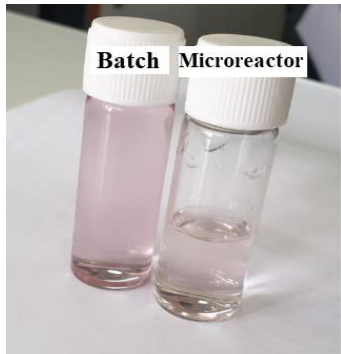
Figure 13 . Colors for GNPs samples prepared in a microreactor at 328.15 K. (Cons of SC, SB, and HAuCl 4 = 0.1 mM, total flowrate of SB and gold with SC = 1.66 × 10 −5 L/s, volumetric ratio of SB/HAuCl 4 = 4:10, pH i = 3) . HAuCl 4 = 0.1 mM, total flowrate of SB and gold with SC = 1.66 SB/HAuCl 4 = 4:10, pH i =